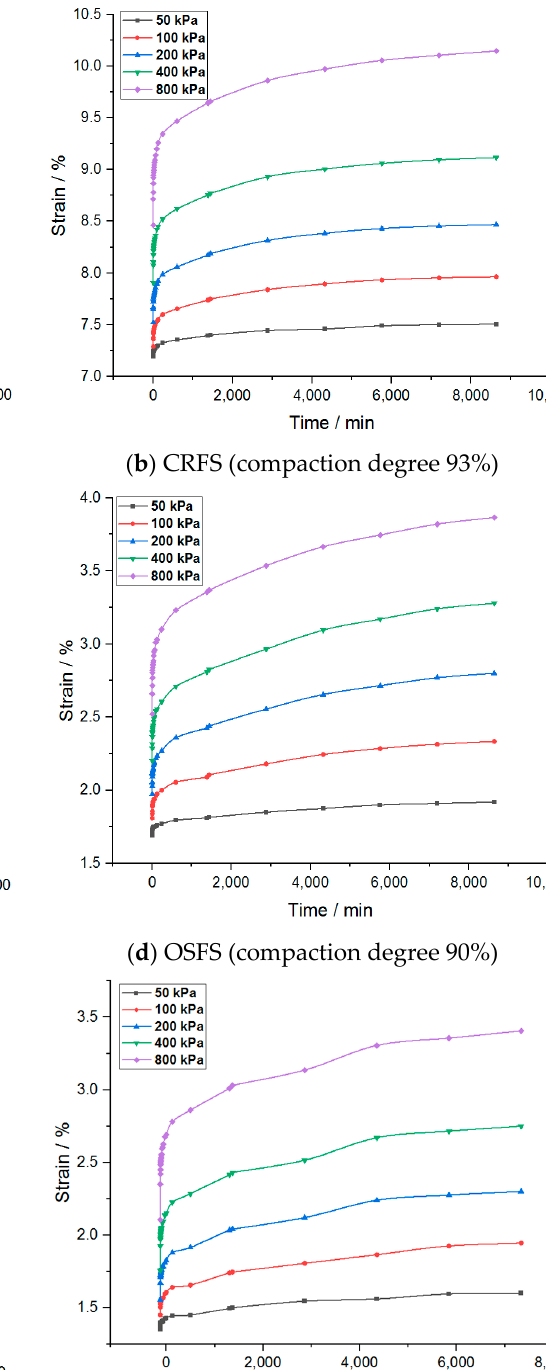
Figure 5. Strain–time curves of samples with different water content after process.